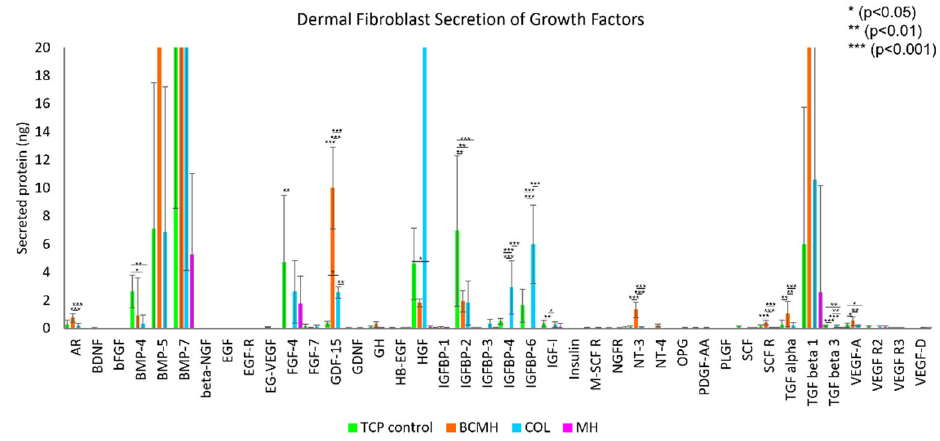
Figure 3. Growth factor data from 0–20 ng, to better visualize lower range of data set. n = 9 for each material.